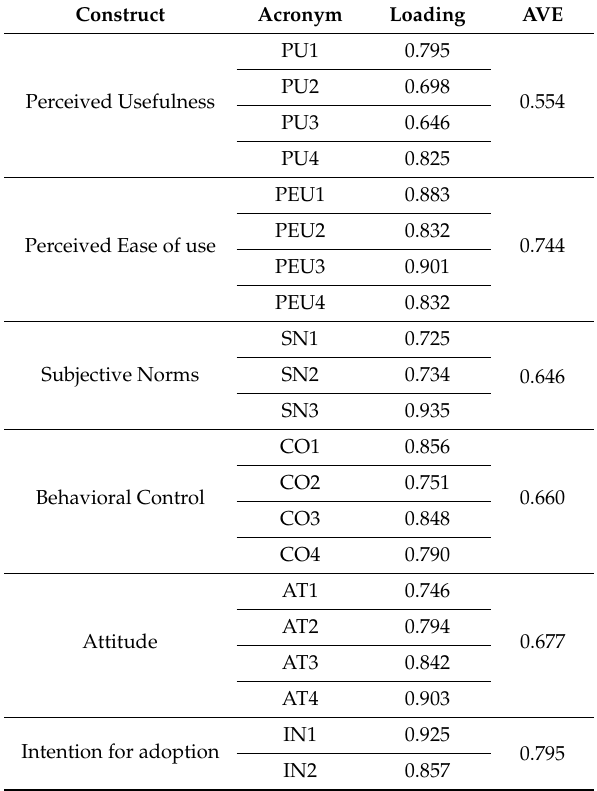
Table 3. The factor load of each item on its related construct and